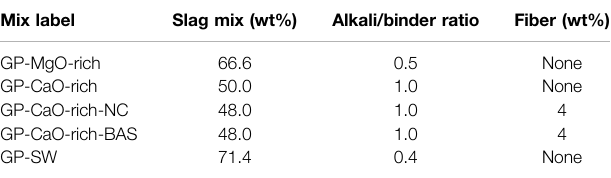
TABLE 1 | Alkali activated materials formulations expressed as weight %. Mix